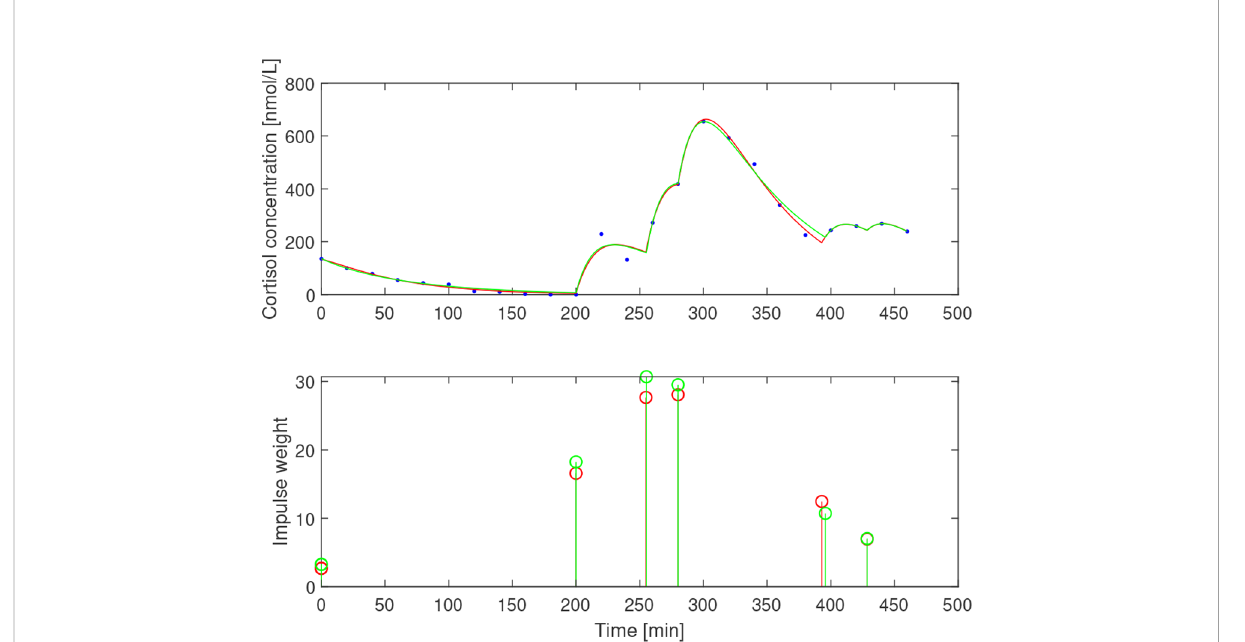
FIGURE 11 Simulated cortisol concentration (top) together with measured values (blue dots) and impulse estimates (bottom) from estimation assuming b 1 =0.05 min − 1 (red) and b 1 =0.065 min − 1 (green) for amenorrheic